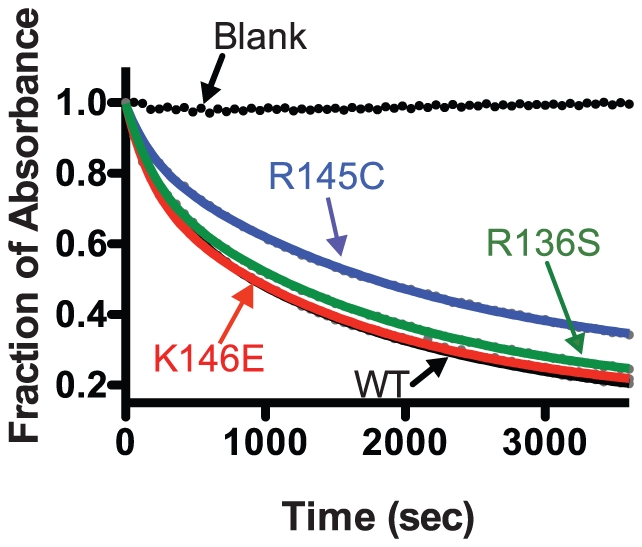
Time course of remodeling of multilamellar DMPC vesicles by wild-type apoE3 and apoE3 variants.Absorbance at 325 nm was followed for 1 hr after addition of apoE3 to DMPC vesicles as described in the materials and methods section. Experimental data (closed circles) were fit to a two-phase exponential decay model (solid lines).